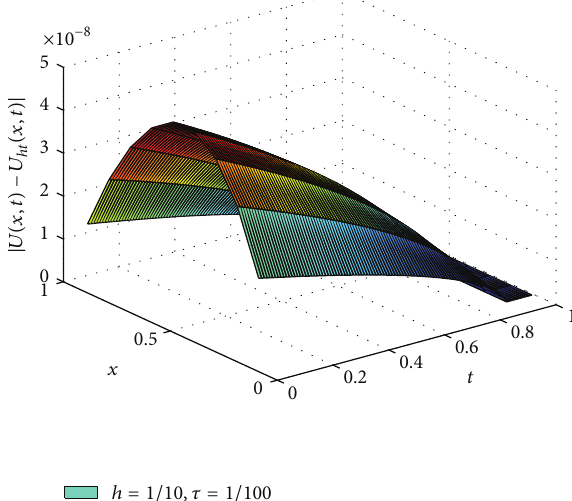
Figure 2: Error surface maps of difference scheme (20)–(22) solving for problem (54) with step-size ℎ = 1/10 ; 𝜏 = 1/100 .